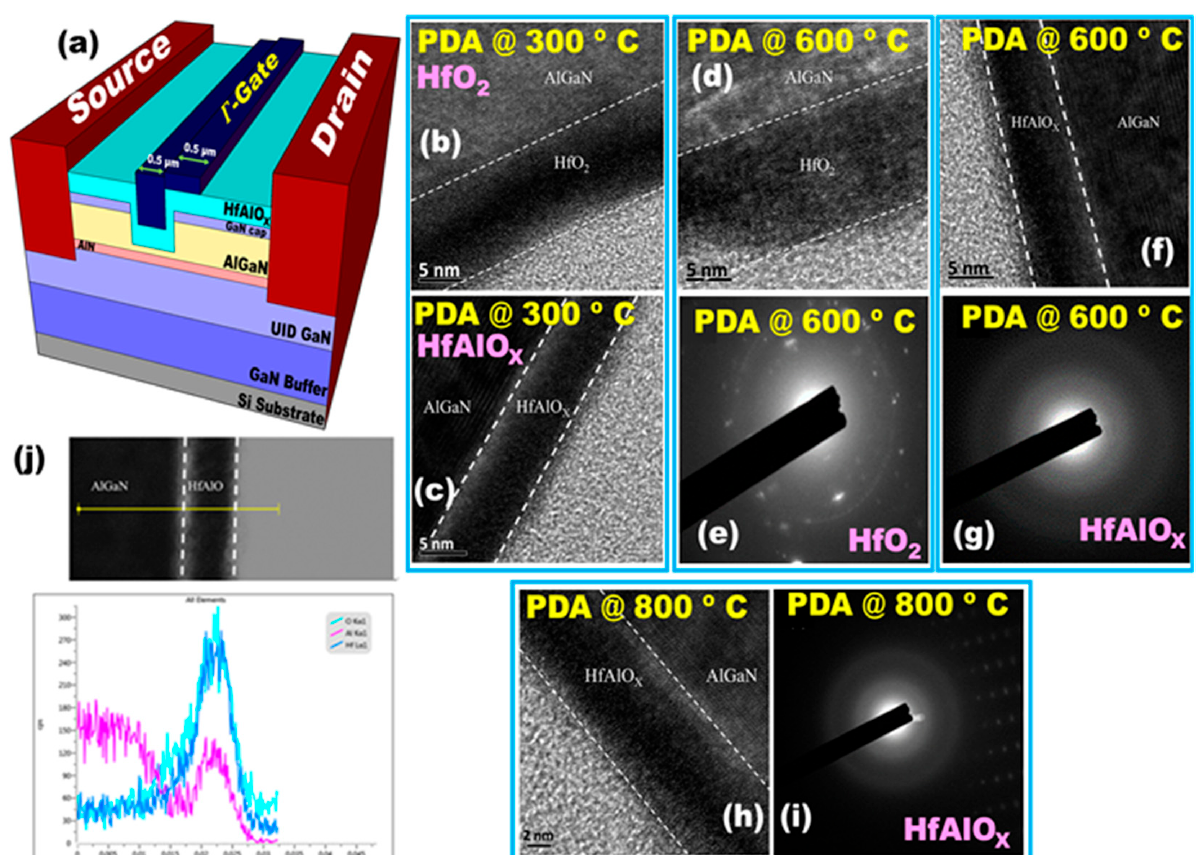
Figure 1. ( a ) Schematic illustration of Γ -shaped gate metal oxide semiconductor high electron mobility transistor (MOS- HEMT). TEM image of Γ -gate ( b ) HfO 2 and ( c ) HfAlO X MOS-HEMT with the post deposition annealing (PDA) at 300 ◦ C. ( d ) TEM image and ( e ) the selected area diffraction pattern (SADP) of Γ -gate HfO 2 MOS-HEMT and ( f ) TEM image and ( g ) selected area diffraction pattern (SADP) of Γ -gate HfAlO X MOS-HEMT with PDA at 600 ◦ C. ( h ) TEM image and ( i ) SADP of Γ -gate HfAlO X MOS-HEMT with PDA at 800 ◦ C. ( j ) EDX line scan of HfAlO X .